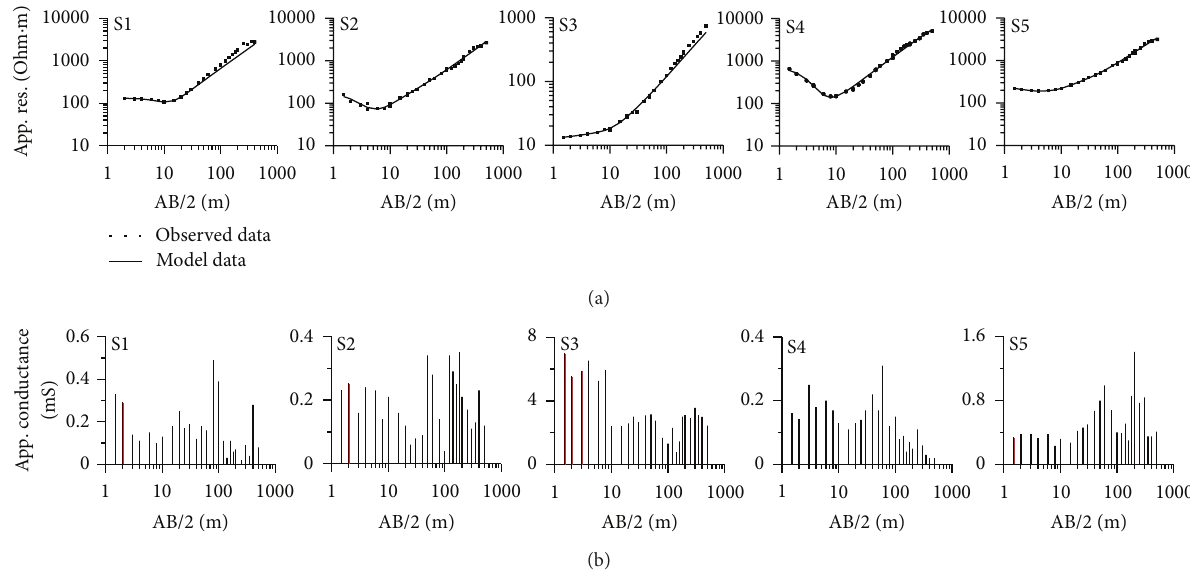
Figure 7: Fitting between the observed (solid dot) and calculated (continuous line) apparent resistivity of all soundings (S1–S5) and their corresponding apparent conductance ( 𝐶 𝐴 ).